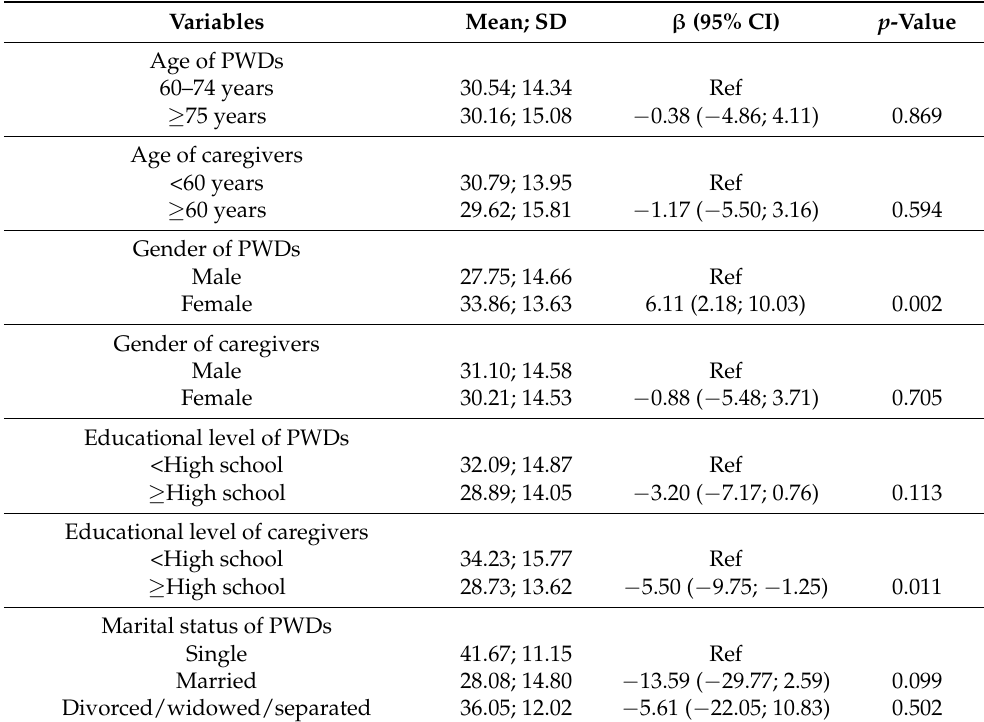
Table 3. The differences in average scores of caregiver burden by independent variables and bivariate analysis of factors associated with caregiver burden ( n =